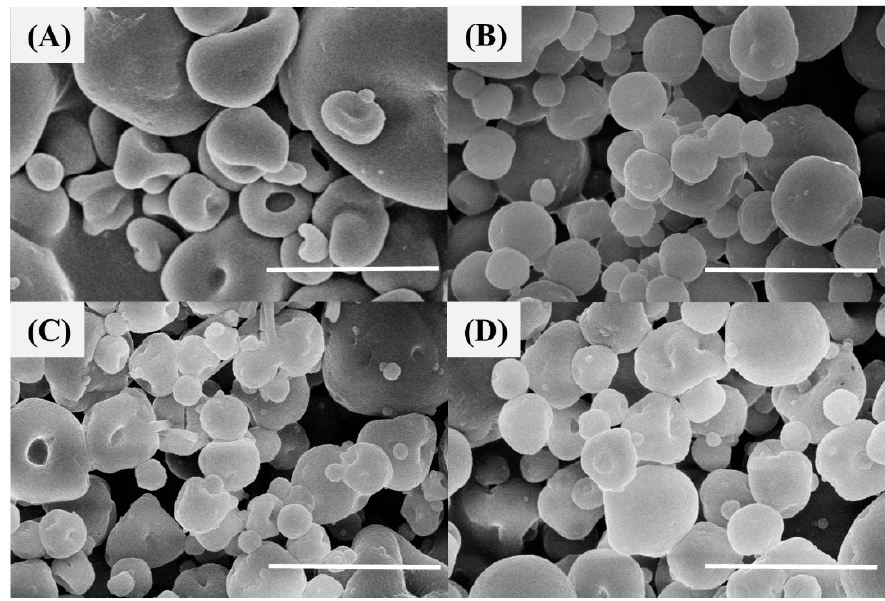
Figure 1. SEM images of microspheres. ( A ) biomimetic alginate/carboxymethylcellulose/gelatin (BACG); ( B ) BACG-1B; ( C ) BACG-3B; ( D ) BACG-6B (scale bar = 5 μ m).